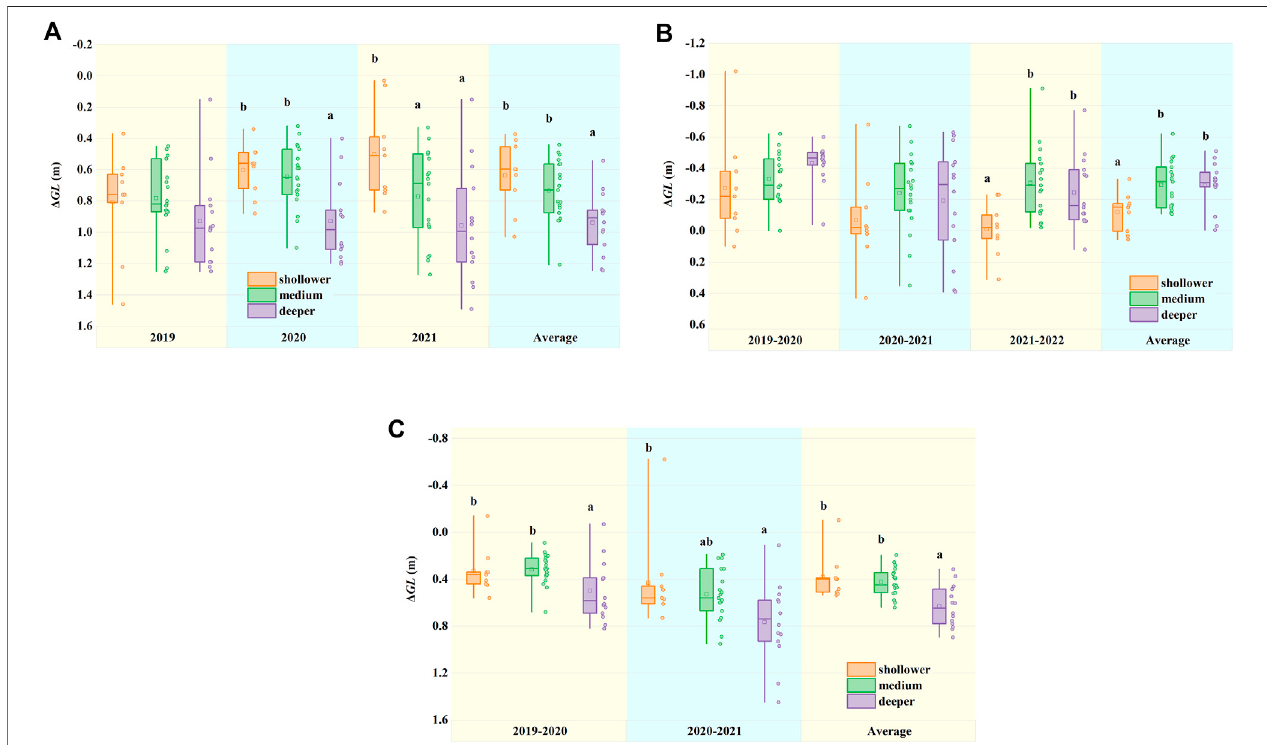
FIGURE3| Changeinthegroundwaterlevel( Δ GL )from2019to2022.Box-whiskerplotsshowthemean(square),median(solidline)intheboxes,andthe5thand 95thpercentilesonthewhiskers. (A) Thegroundwaterdischarge(irrigation)period,with Δ GL fromApriltoOctoberwithintheyear; (B) Thegroundwaterrechargeperiod, with Δ GL from October tothe following April; and (C) Δ GL interannual , which represents the net change from October to the following October. The statistical signi fi cances are marked with lowercase letters ( p < 0.05).